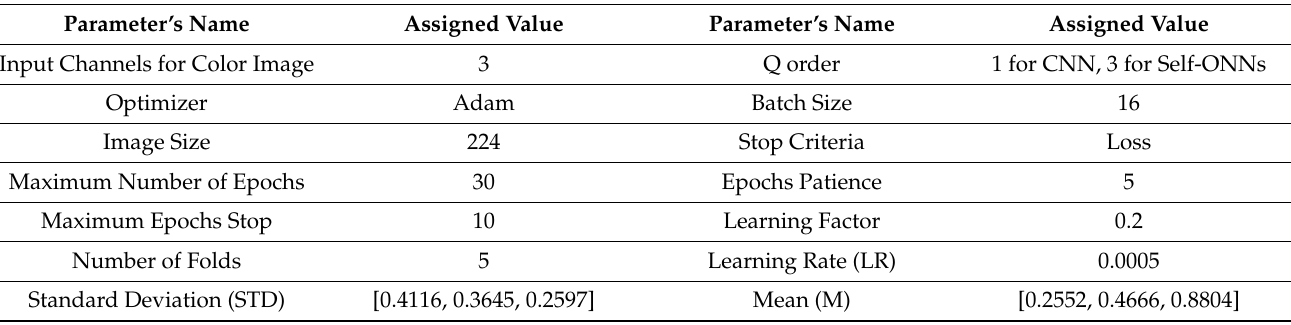
Table 3. Hyperparameters for all classification models.